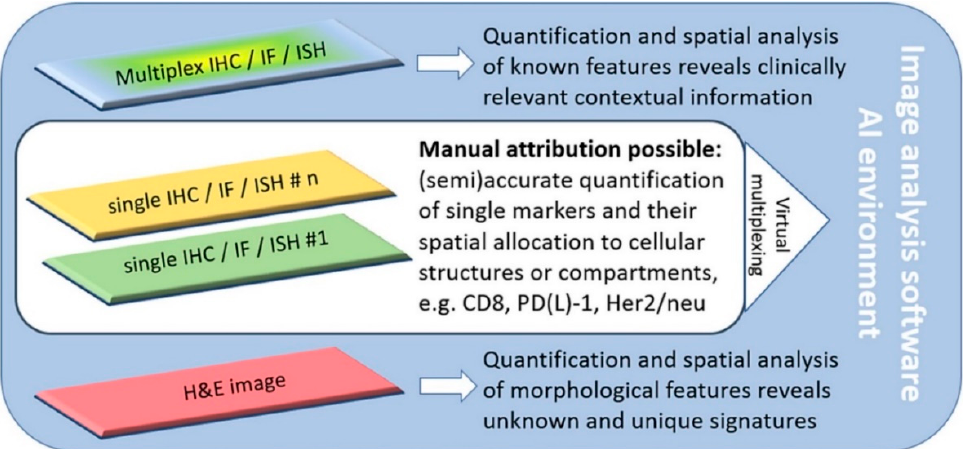
Figure 1. Software-assisted decision support in digital histopathology. Most current problems in routine histopathology can be solved with software-guided image analysis tools. The increasing emergence of complex multiplex analysis allows for the consideration of the tumor heterogeneity and the spatial relationships of various markers. If single-slide multiplexing is not possible due to inconsistent antigen-retrieval or disparate staining protocols, virtual multiplexing is also an option. Novel artificial intelligence (AI) solutions even allow novel and unique signatures from H&E slides to be revealed. Reproduced with permission from J. Pathol. 2020 , 250 , 685–692, doi:10.1002/path.5388 [8].